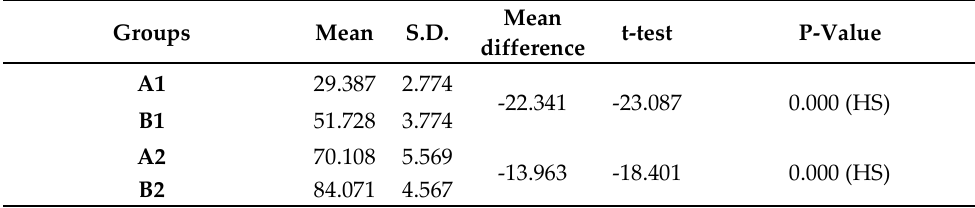
Table 3: The Paired sample T- test for effect of different CAD/ CAM on the marginal